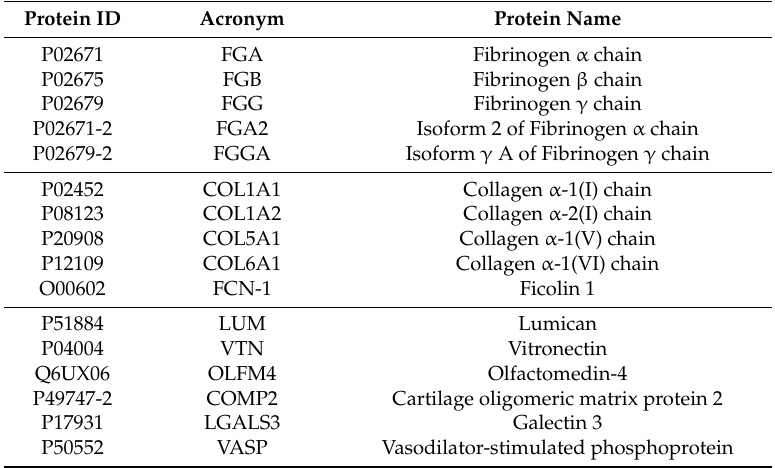
Table 6. Proteinases and peptidases in wound fluids.